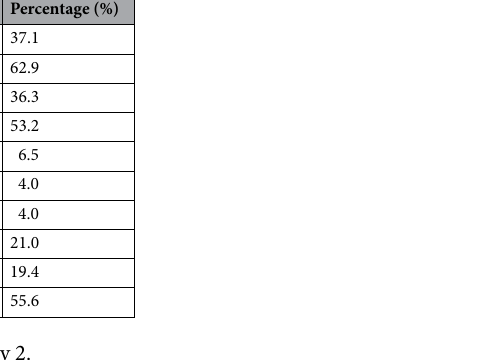
Table 6. The demographic information of Study 2.